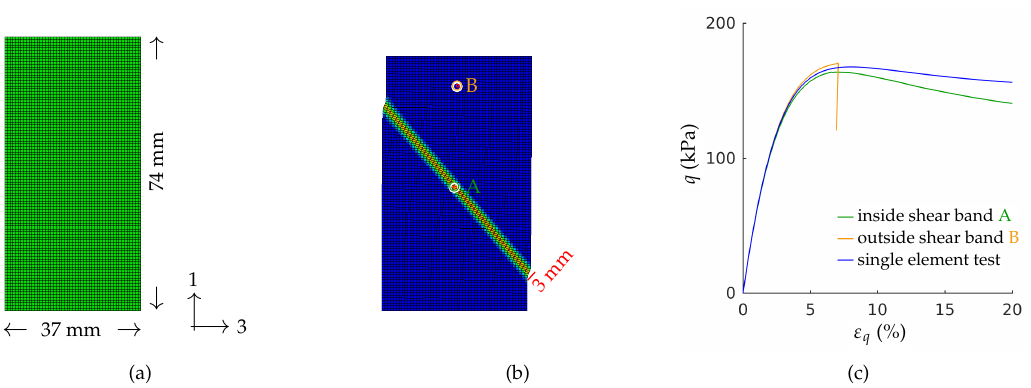
Figure 4. ( a ) FE model ( b ) Final shear band at global deviatoric strain of ε q = 8.8%, displayed as deviatoric strain, green: ε q = 22% to red: ε q = 53% ( c ) Stress-strain curves in- A and outside B the shear band, single element test.